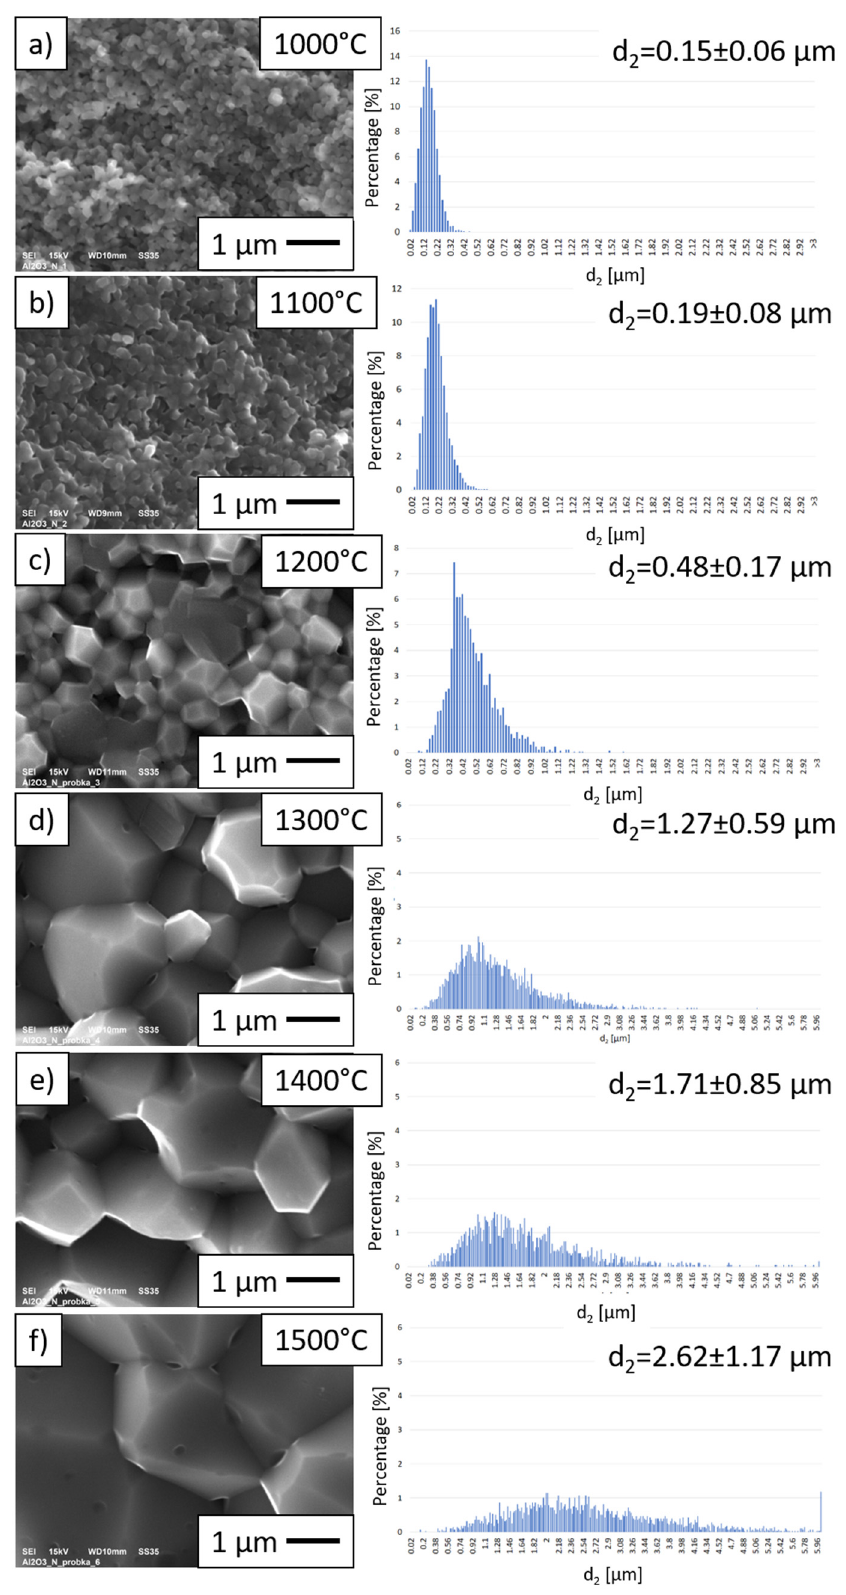
Figure 7. The fracturing of Al 2 O 3 samples sintered by the PPS method ( a ) at 1000 ◦ C; ( b ) at 1100 ◦ C; ( c ) at 1200 ◦ C; ( d ) at 1300 ◦ C; ( e ) at 1400 ◦ C; ( f ) at 1500 ◦ C, and histograms showing the size distribution of Al 2 O 3 grains.